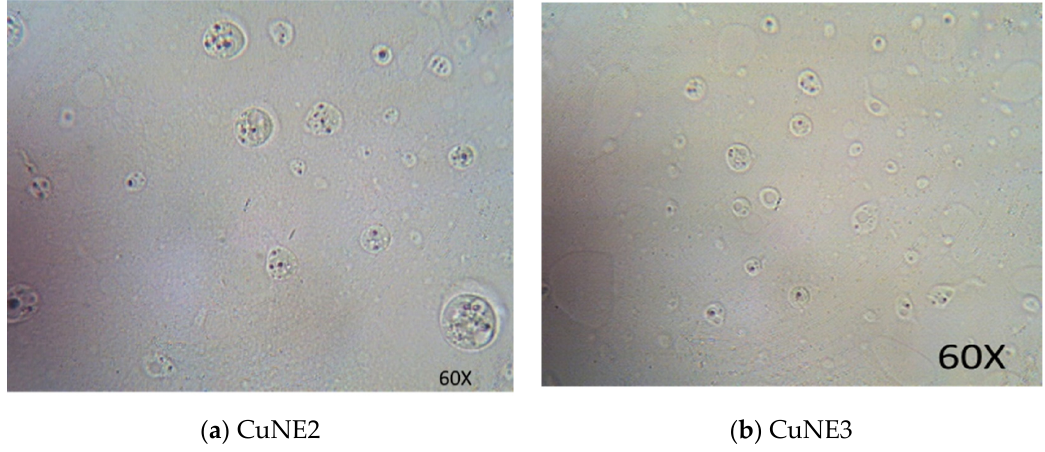
Figure 2. Optical image for curcumin encapsulation in different nanoemulsion sample.